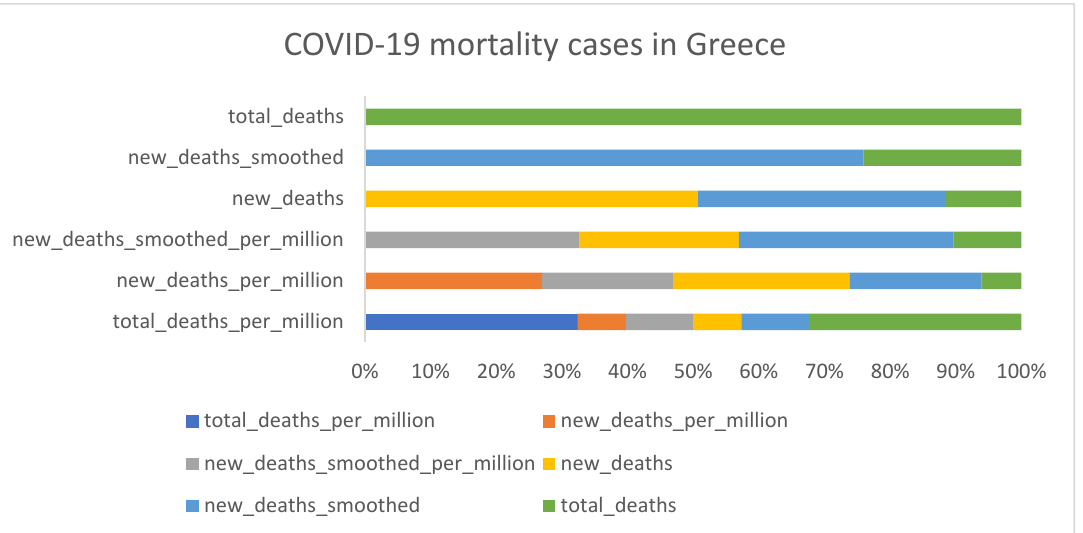
Figure 4. Weekly COVID-19 cases in Israel.